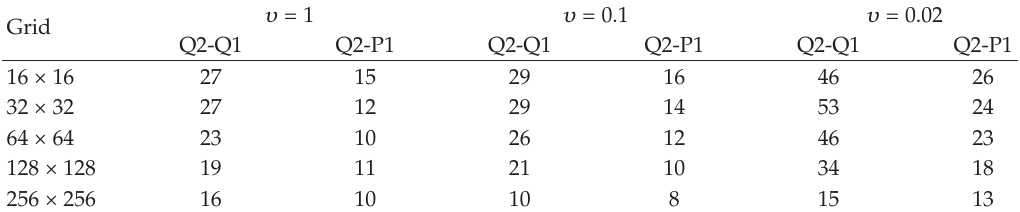
Table 3: Iterations of preconditioned GMRES (cid:4) 30 (cid:5) for steady Oseen problems (cid:4) Newton (cid:5)